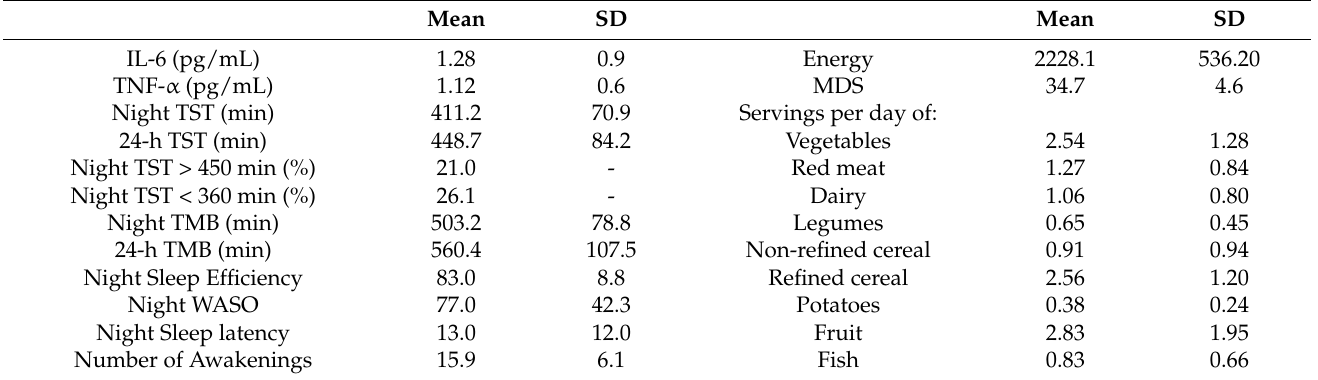
Table 2. Inflammatory markers, sleep, diet, and physical activity levels of the entire sample ( n =